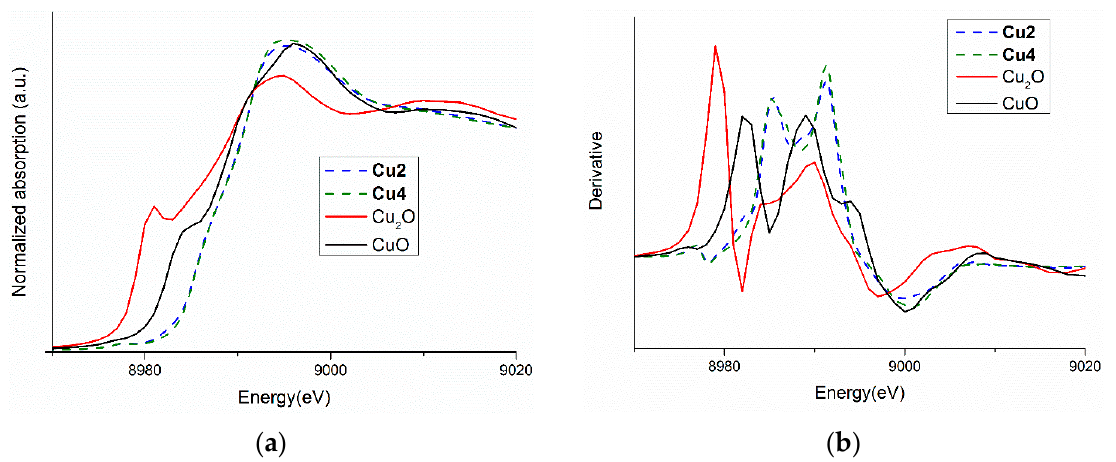
Figure 5. ( a ) Cu K-edge spectra of two complexes Cu2 , Cu4 , and two reference oxides: Cu 2 O, CuO, and ( b ) their first derivatives.